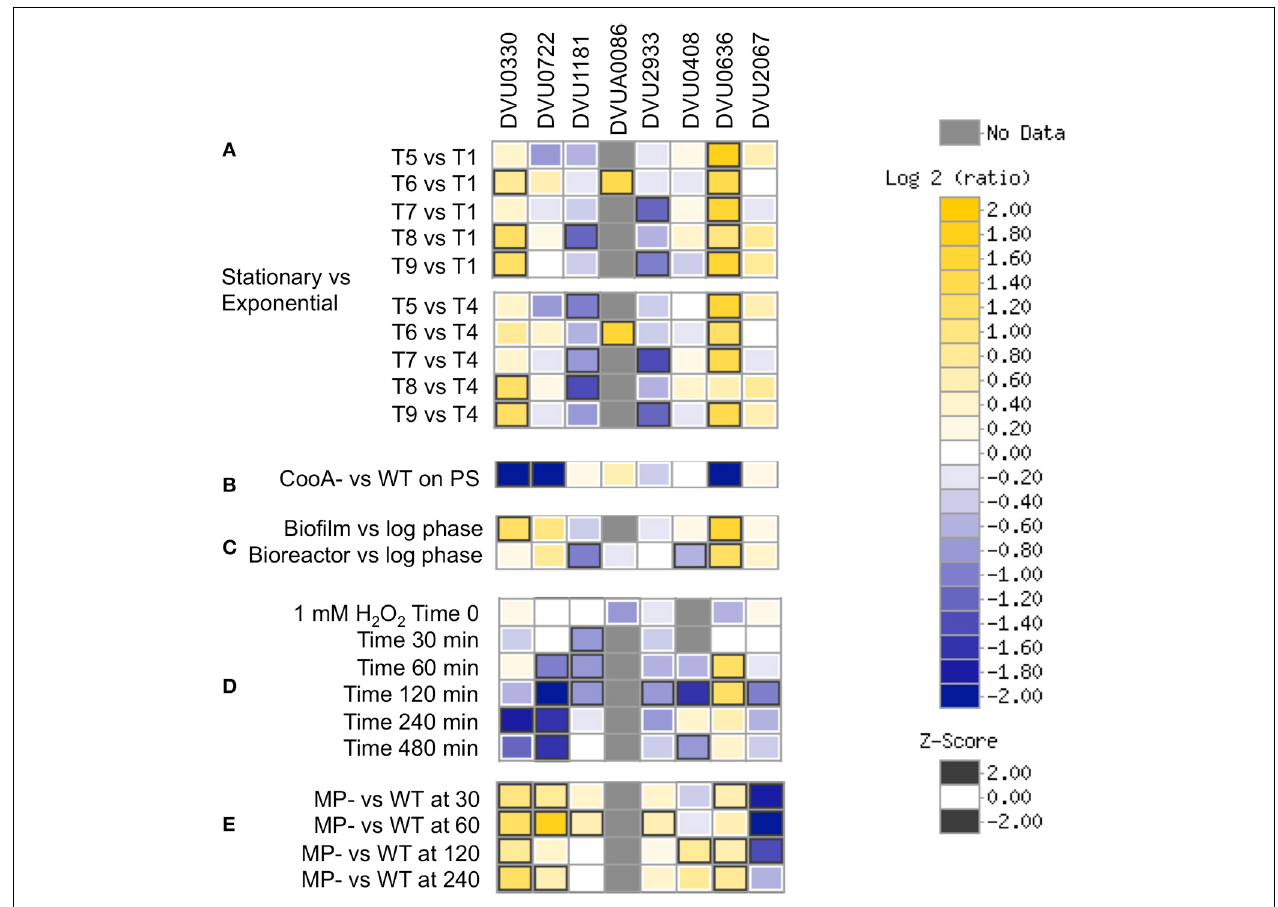
FIGURE 10 | Transcriptomics data showing relevant conditions for differential expression of the 8 RRs. (A) Stationary vs. Exponential phase where T1-T2 are exponential phases, T3-T4 are late exponential phases, T5 is early stationary, and T9 is late stationary (Clark et al., 2006). (B) CooA mutant (Deletion in DVU2097) vs. WT on pyruvate